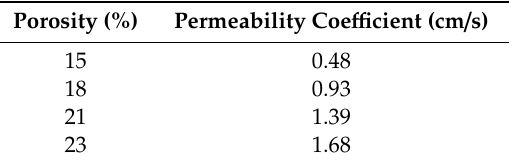
Table 1. Permeability coe ffi cients of PAC16 rut test specimens with di ff erent void content.